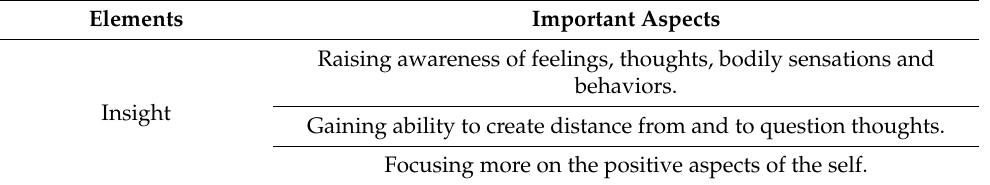
Table 3. Cont. Elements Important Aspects Raising awareness of feelings, thoughts, bodily sensations and behaviors. Insight Gaining ability to create distance from and to question thoughts. Focusing more on the positive aspects of the